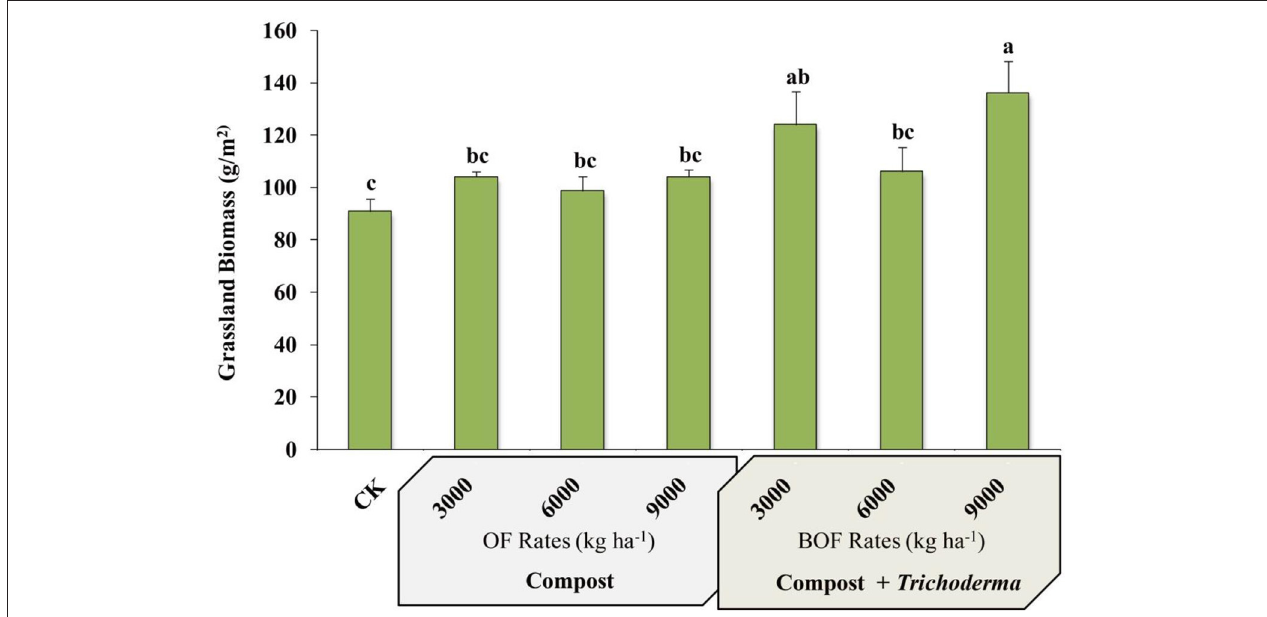
FIGURE 1 | Grassland biomass by fertilization regime. CK: non-amended; OF 3000: 3,000kg ha − 1 organic fertilizer (composted cattle manure); OF 6000: 6,000kg ha − 1 organic fertilizer; OF 9000: 9,000kg ha − 1 organic fertilizer; BOF: 3,000kg ha − 1 biofertilizer (composted cattle manure + Trichoderma inoculum); BOF 6000: 6,000kg ha − 1 biofertilizer; BOF 9000: 9,000kg ha − 1 biofertilizer. Data from each treatment were analyzed using one-way analysis of variance (ANOVA). Bars represent mean values of three replicates ± SE. Bars that do not share a letter are significantly different ( p < 0.05).